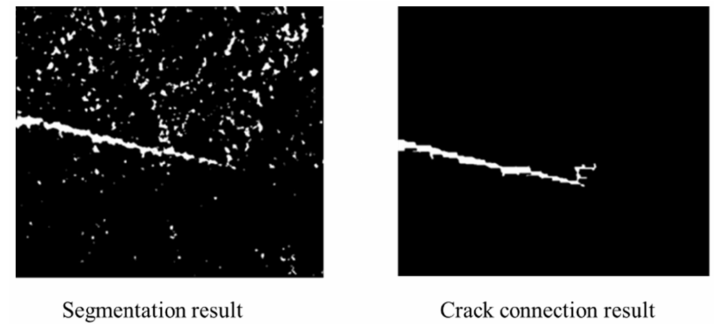
Figure 21. Image details of the reason for